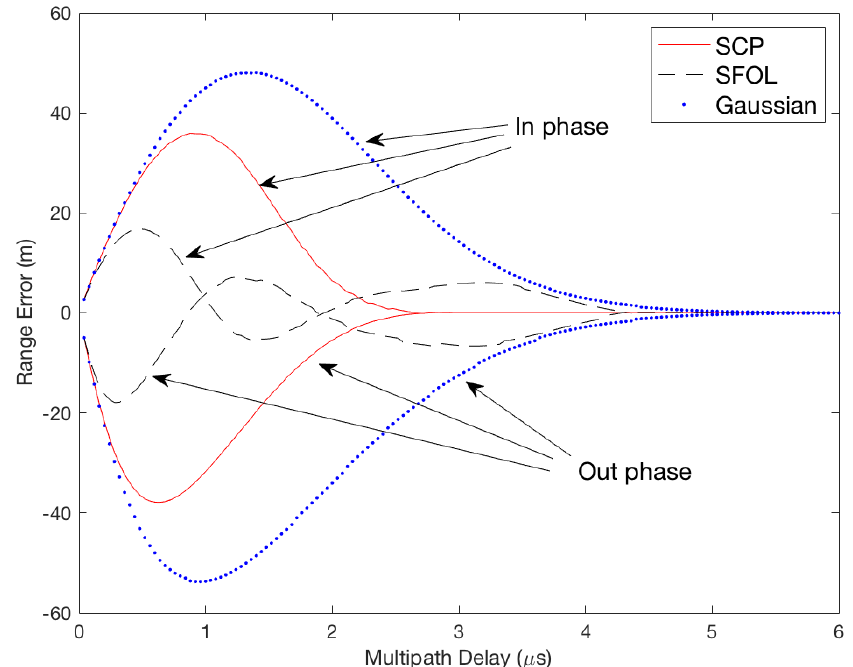
Figure 2. Range error envelopes due to in-phase and out-of-phase multipaths for SCP, SFOL, and Gaussian pulses.